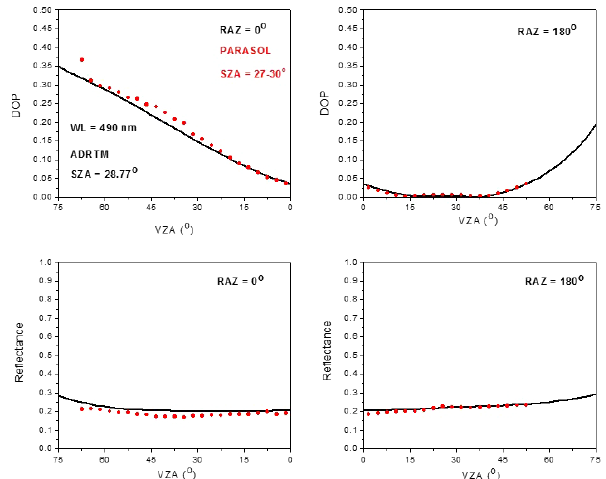
Figure 2. Comparison of the modeled DOP and reflectance of desert-reflected solar light at relative azimuth angles (RAZs) of 0 and 180 ◦ with those from the PARASOL data at the wavelength of 490nm. The solar zenith angle (SZA) is 28.77 ◦ in the modeling. The SZA is in the bin of 27–30 ◦ for the PARASOL data.